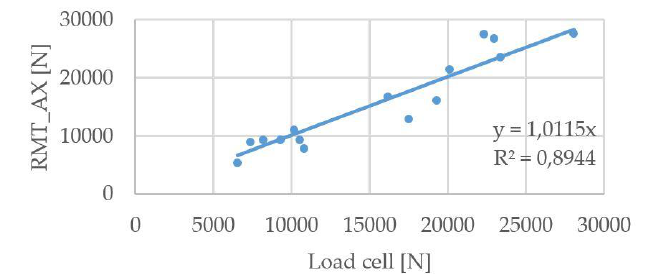
Figure 4. Comparison between the force values measured by the load cell and the wheelchair RMT_AX